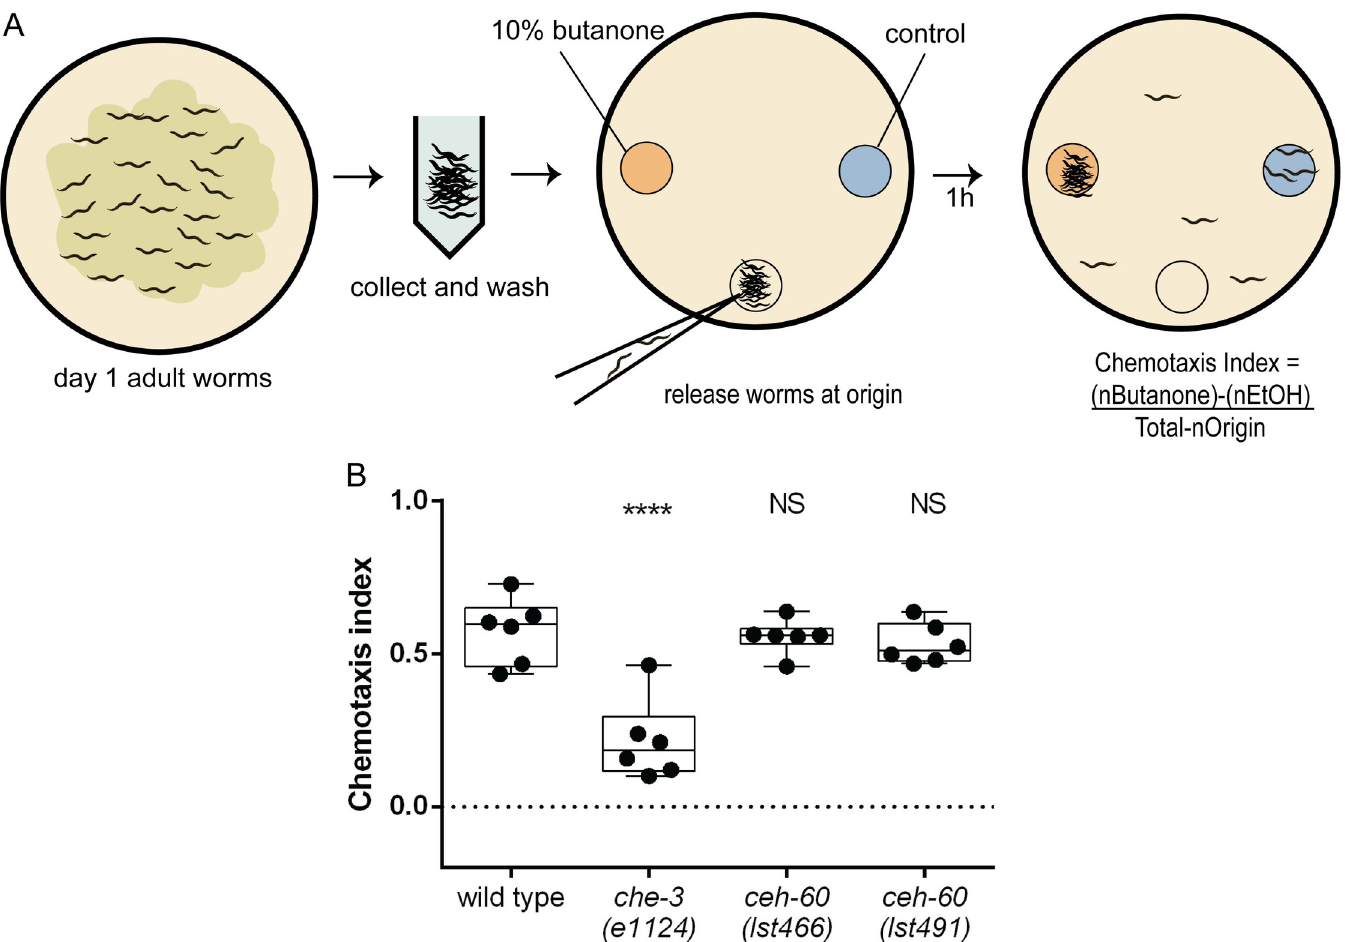
Fig 3. ceh-60 mutants have normal butanone sensing capacity. (A) The butanone sensing assay experimental setup. Animals are collected, washed to remove residual bacteria and released at the origin of a chemotaxis plate, to which 10% butanone (orange) and control (blue) spots have been applied (details: methods). After 1 hour, the chemotaxis index is calculated as CI = ([(nButanone)-(nEtOH)]/[(Total-nOrigin)], with n the number of animals at these positions. (B) Wild-type animals are able to sense butanone, as evidenced by their positive CI. che-3(e1124) animals have a documented defect in sensing butanone, and their (significantly lower) CI is used as a positive control for the assay. Neither ceh-60 mutant strain shows a significant difference in CI. ���� p < 0.0001. NS, not significant. Each dot represents an assay of a biologically independent population, N =